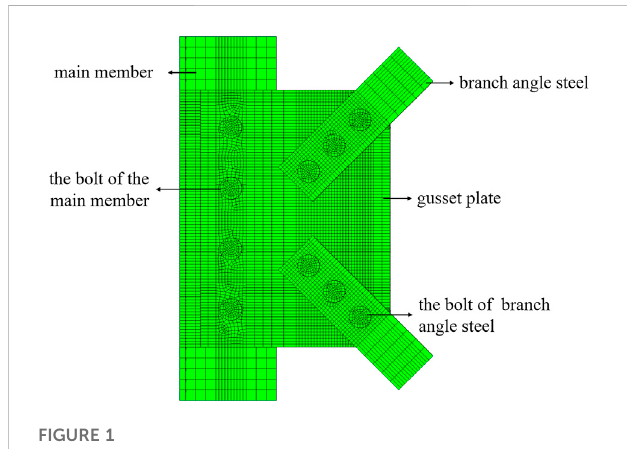
FIGURE 1 Finite element model of the K-joint.